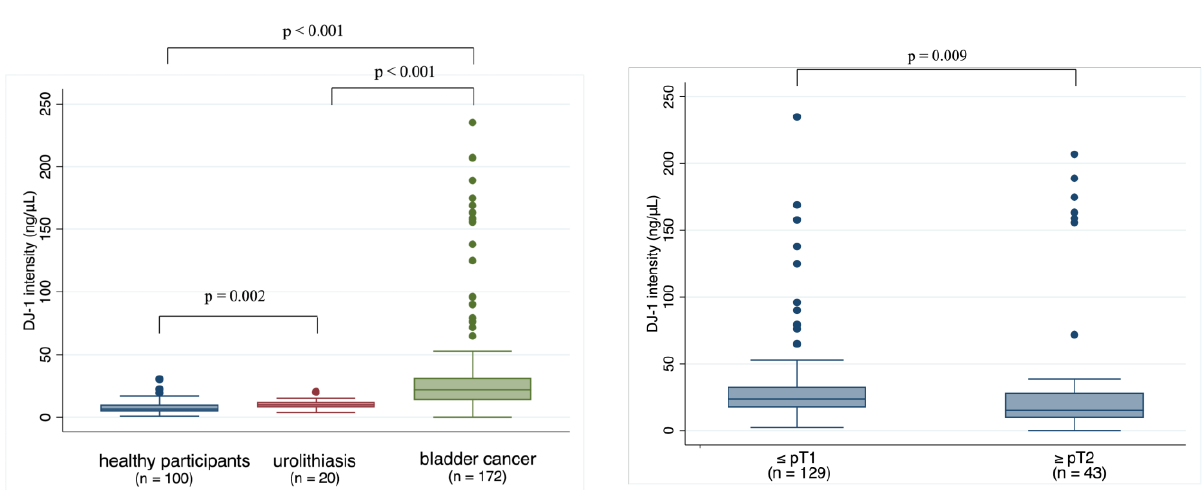
Figure 1. Serum concentrations of DJ-1 protein by reverse-phase protein array analysis ( A ) in patients with bladder cancer or urolithiasis and in healthy participants, and ( B ) in patients with non-muscle-invasive bladder cancer and muscle-invasive bladder cancer.